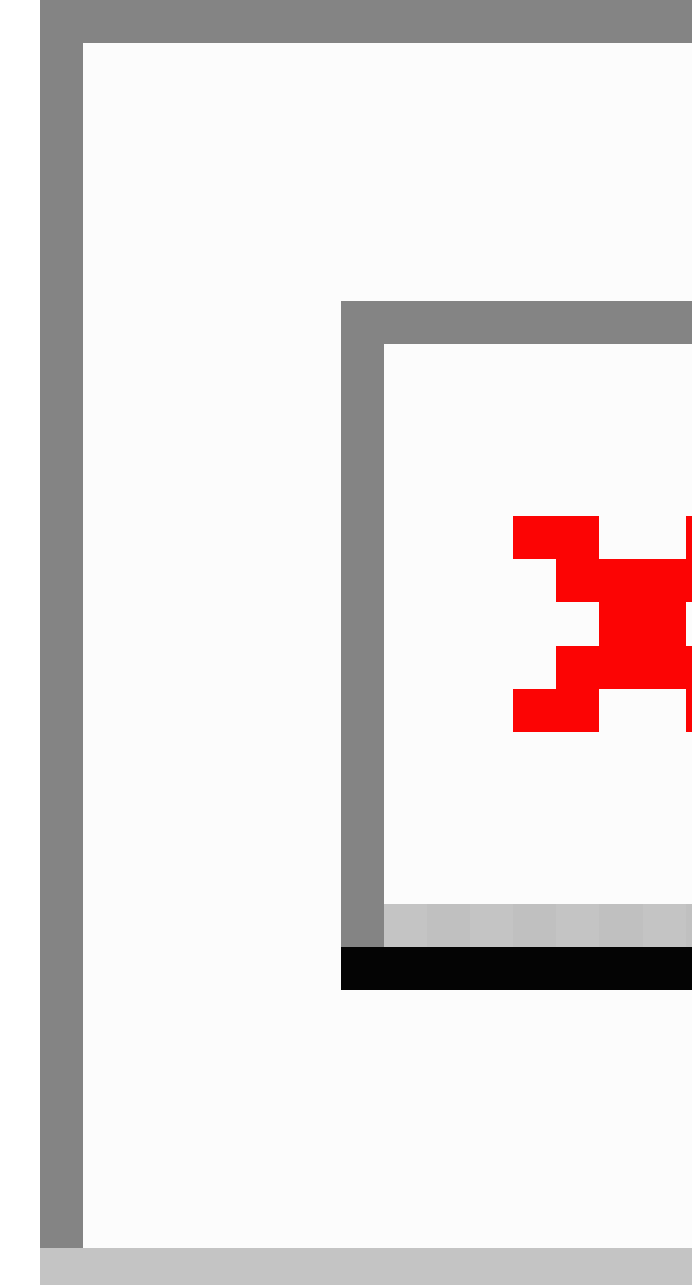
Figure 6. Geographic heat map of user traffic (source: Google Fusion